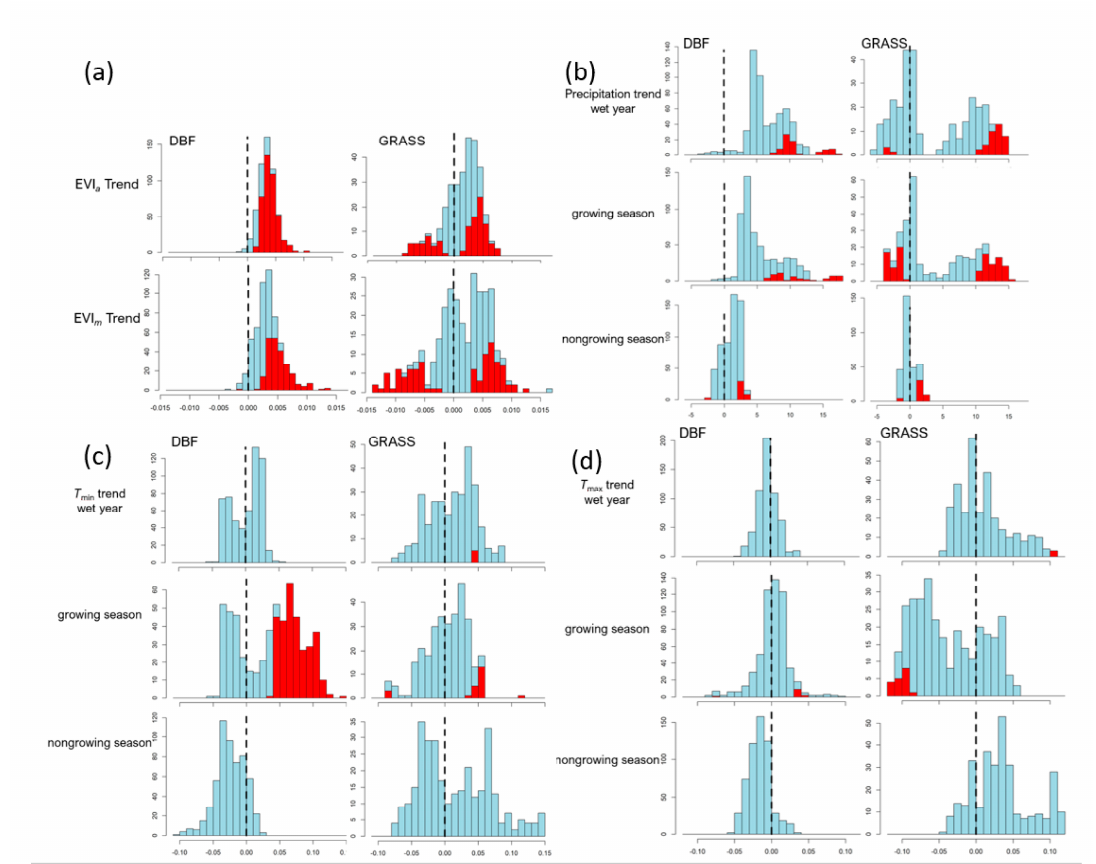
Figure A1. Histograms of trends of averaged and maximum EVI (yr −1 ) ( a ) during growing season, May–September, and of total precipitation ( b ), average minimum temperature T min ( c ), and average maximum temperature T max ( d ) during wet year (prior October to September), growing season (May to September), and nongrowing season (prior October to April) in 2001–2015 for the grassland (GRASS) and deciduous-broadleaved forest (DBF) patches. EVI a and EVI m indicate averaged and maximum EVI during growing season, respectively. Red bars on the left side of the dashed line indicate those trends significantly lower than 0 while those on the right side of the dashed line indicate the trends significantly greater than 0 ( p -value < 0.025, one-tail test).